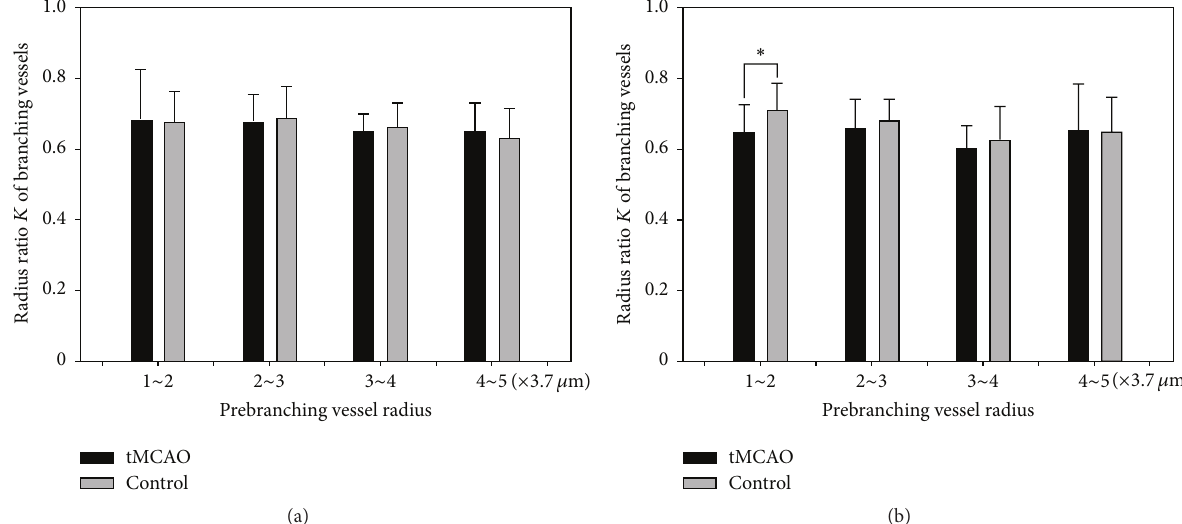
Figure 7: Microvasculature changes in contralateral (a) and ipsilateral (b) brains after 14-day reperfusion from tMCAO model. In ipsilateral brain, for the branching vessels with radius < 7.4 𝜇 m, brain injury group demonstrated a statistically significant change in vessel radius ratio 𝐾 (defined as the radius ratio of postbranching vessel to prebranching vessel) compared with that in the sham group. ∗ Student’s 𝑡 -test 𝑝 < 0.05